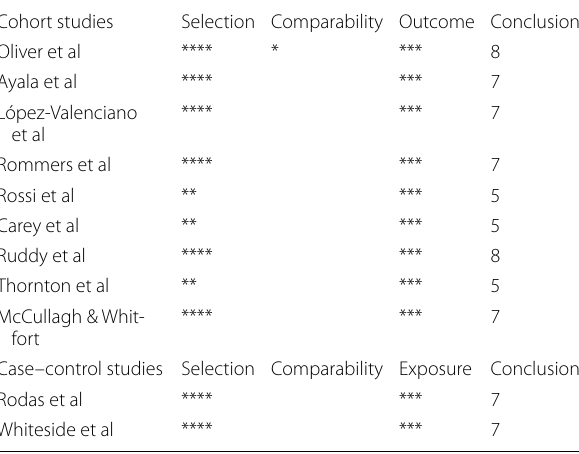
Table 2 Methodological quality of the included studies using the NOS scale [45]